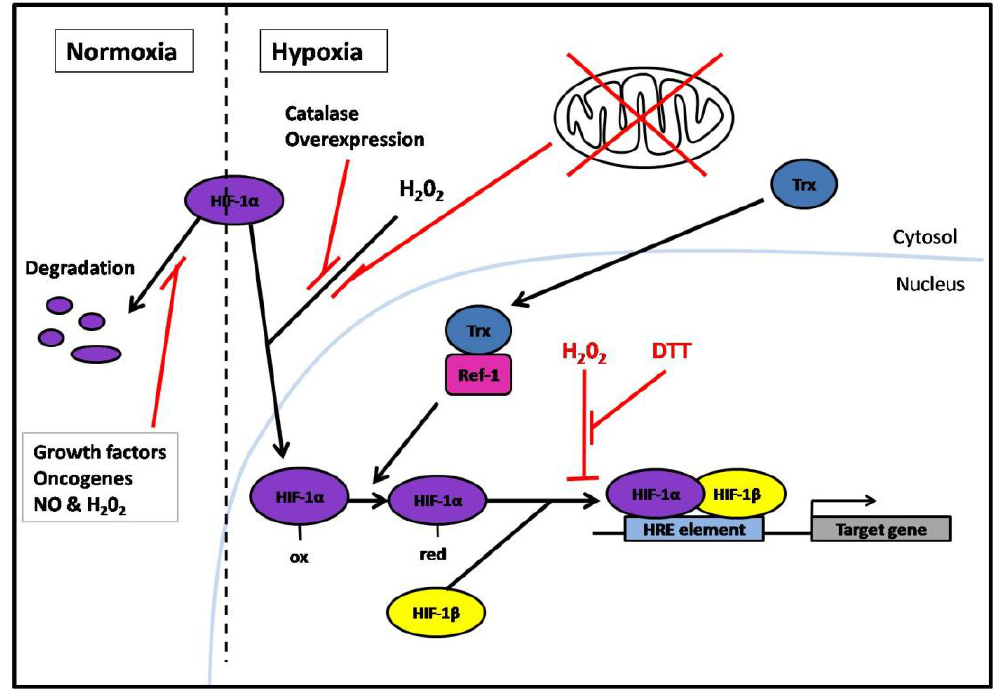
Figure 4. Thioredoxin (Trx) and ROS in the hypoxic stress response. Under normoxia HIF-1α is degraded in the cytosol while in hypoxia HIF-1α becomes stabilized and translocates to the nucleus. In hypoxia, the presence of H HIF-1α stabilization. In the nucleus, reducing conditions are necessary for HIF-1 DNA binding. Trx reduces Ref-1 in the nucleus, which in turn reduces the HIF-1α subunit, which then dimerizes with HIF-1β to form HIF-1. The HIF-1 protein binds to the HRE element and induces transcription of its target genes. Red lines indicate an inhibitory effect. Red cross indicates non-functional